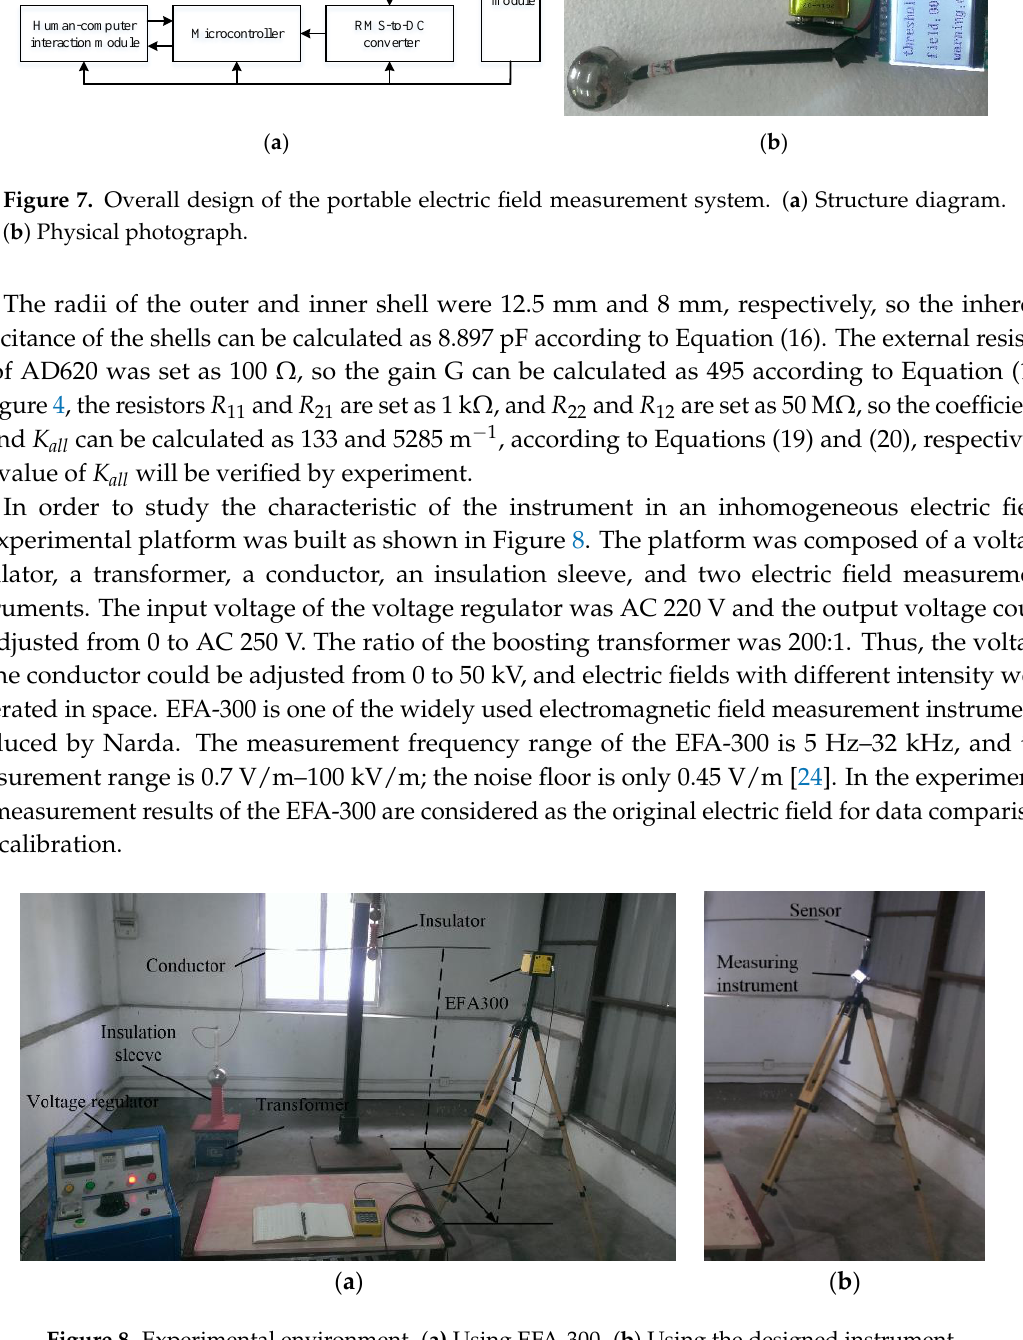
Figure 8. Experimental environment. ( a) Using EFA-300. ( b ) Using the designed instrument.